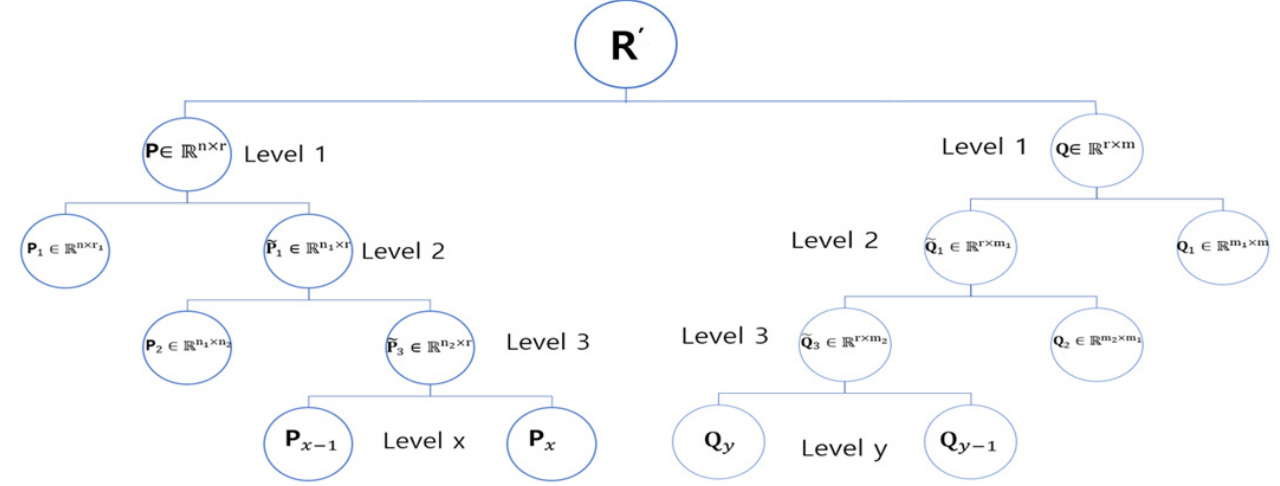
Figure 8. The design of generating products and customers’ implicit dormant features.